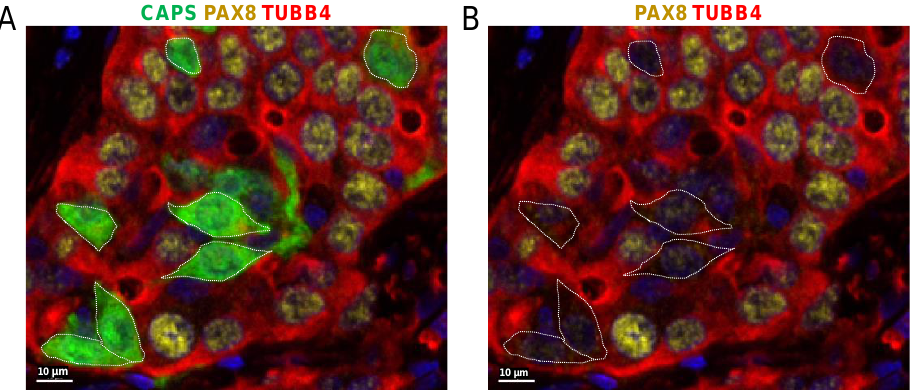
Figure 3. The nuclei of CAPS+ cells in HGSOC do not express PAX8. ( A ) CAPS, PAX8, and TUBB4 mIF, DAPI counterstain. ( B ) Same image as in ( A ) but without the CAPS channel (CAPS+ cells are outlined with a dotted line) for better visualization of the nuclear PAX8 staining.